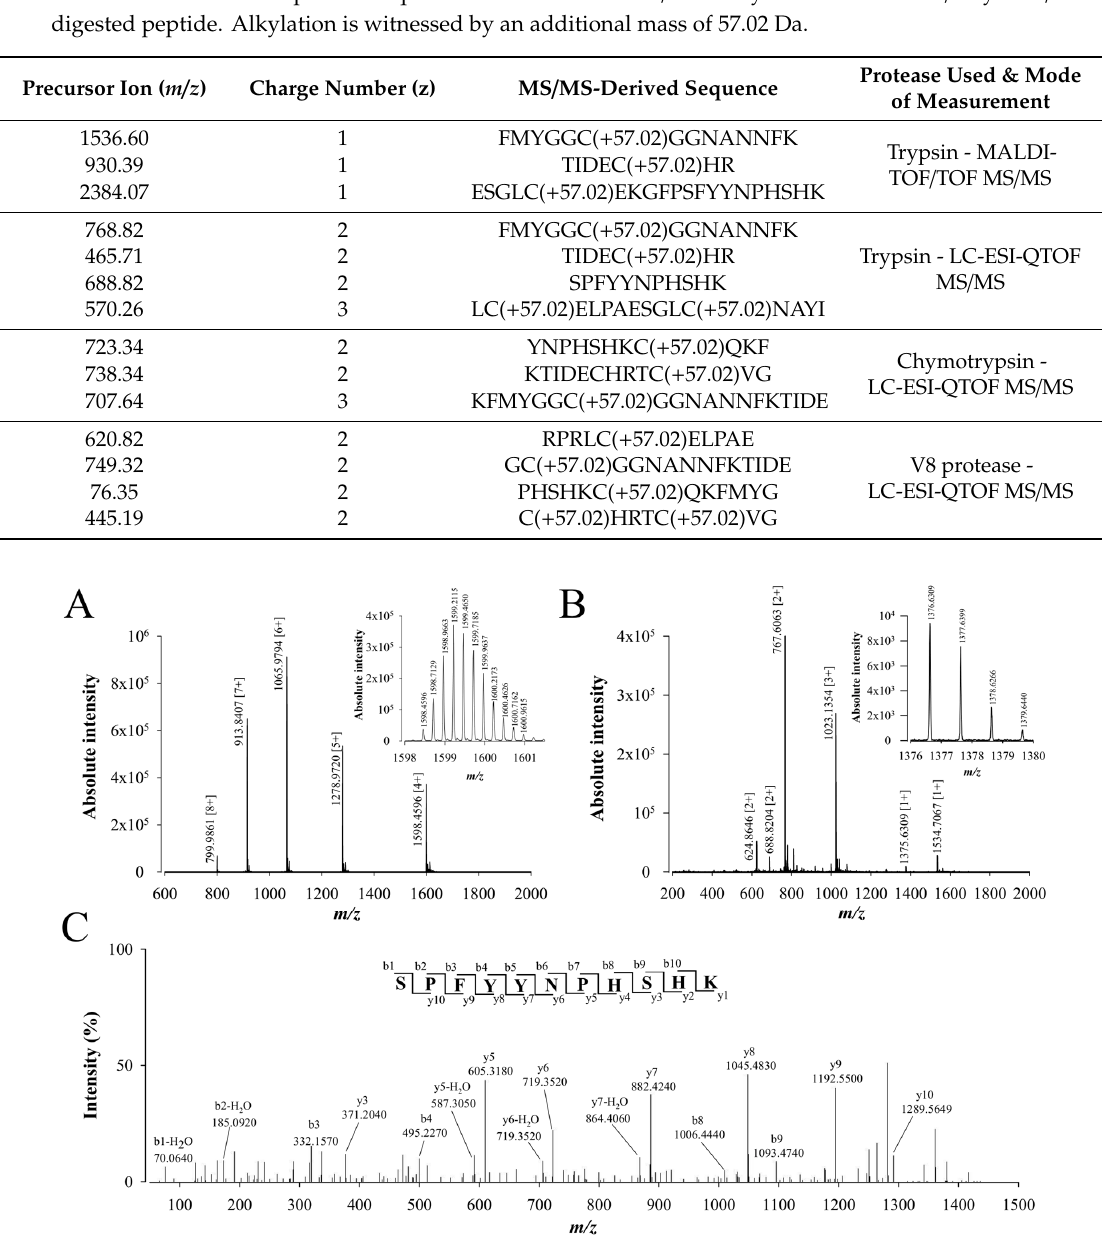
Figure 5. De novo sequencing of compound 1 from fraction F11 by LC-ESI-QTOF MS/MS after reduction, alkylation and protease digestion. ( A ) LC-ESI-QTOF MS of compound 1 (linear positive mode). Inset illustrates the MS of m/z 1598.4596 [4+]. ( B ) LC-ESI-QTOF MS of compound 1 after reduction, alkylation and trypsin digestion. Inset illustrates the MS of m/z 1375.6309 [1+]. ( C ) LC-ESI- QTOF MS/MS of precursor ion m/z 1375.6309. The peptide sequence SPFYYNPHSHK is derived by de novo peptide sequencing. Peaks corresponding to the y and b ions from this peptide are labeled on the spectrum.